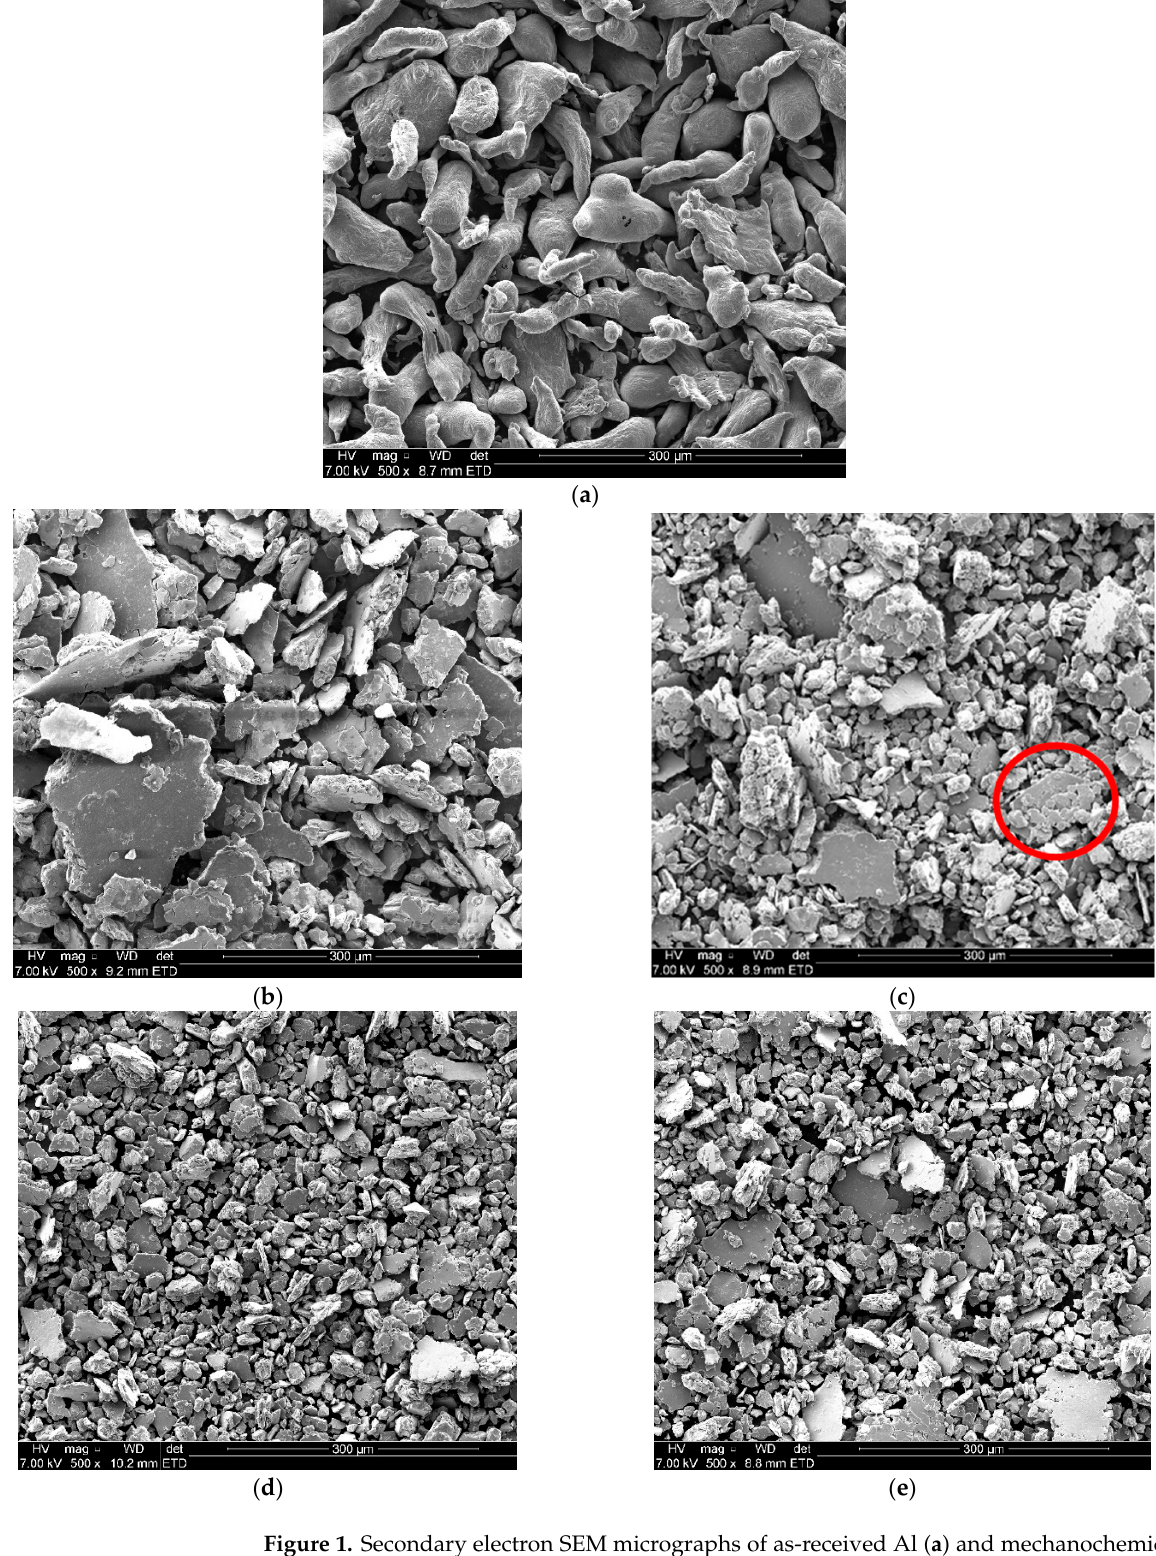
Figure 1. Secondary electron SEM micrographs of as-received Al ( a ) and mechanochemically pro- cessed Al-10% Bi ( b ), Al-9.5% Bi-0.5% Ni ( c ), Al-9.25% Bi-0.75% Ni ( d ), and Al-9% Bi-1% Ni ( e ) com- posite particles.